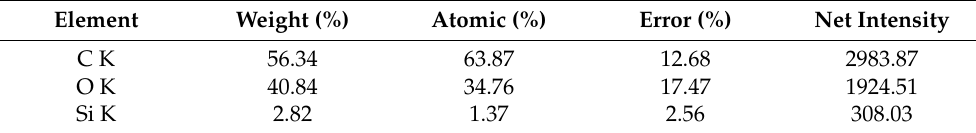
Table 3. Chemical composition of PLA.